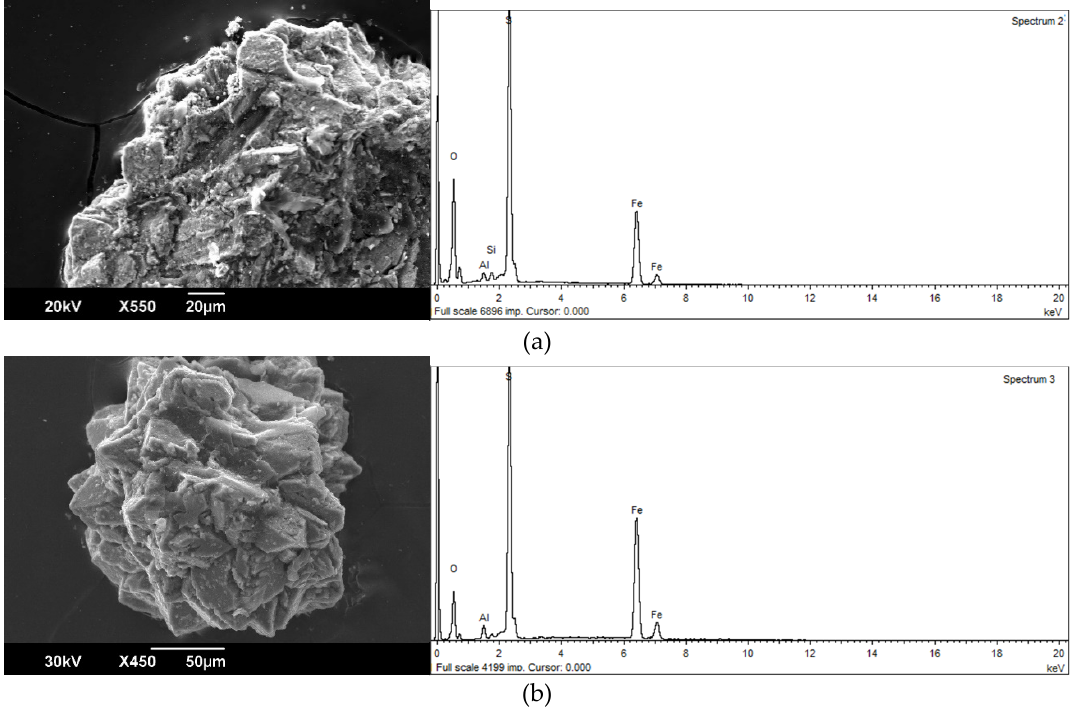
Figure 2. Clayey particles with pyrite from the Kosva River alluvium: ( a ) a fragment of a coal particle with pyrite crystals on the surface, ( b ) an aggregate of cubic and octahedral pyrite crystals isolated from the coal